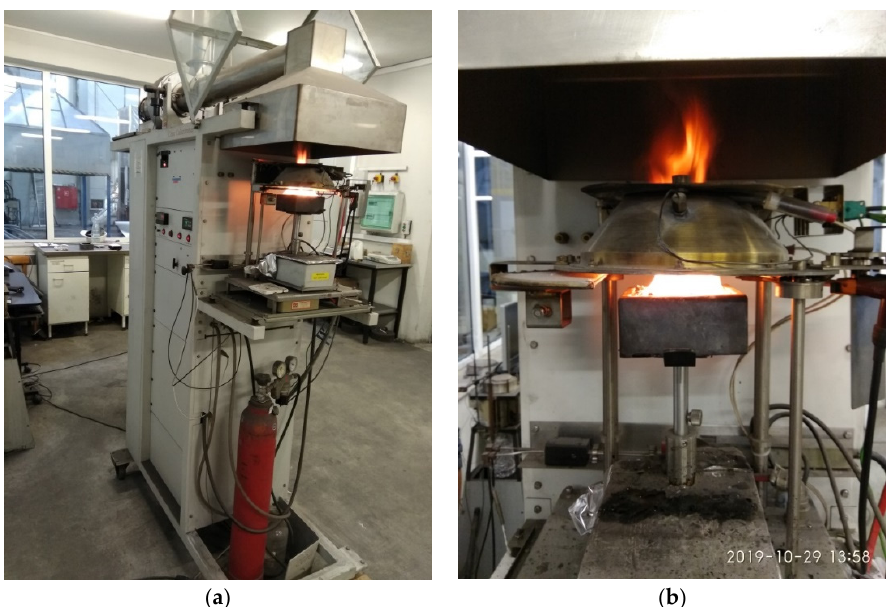
Figure 1. External view of EN 50399 standard test chamber at the accredited ITB Fire Testing La- boratory in Pionki, Poland.